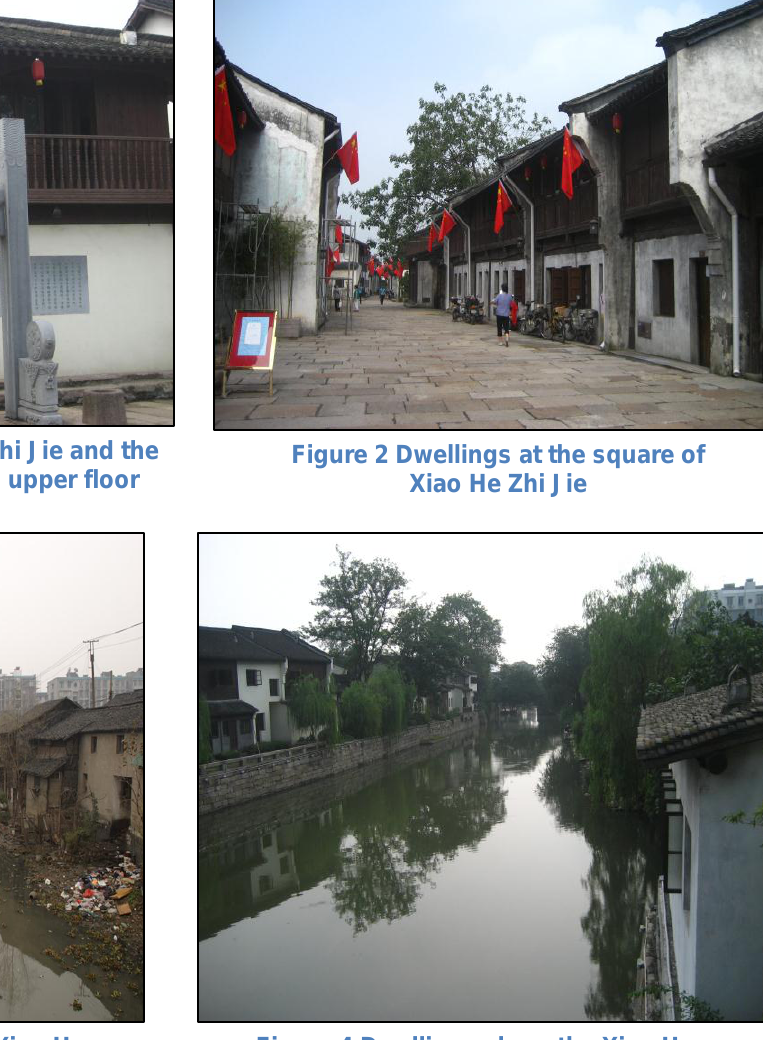
Figure 4 Dwellings along the Xiao He after